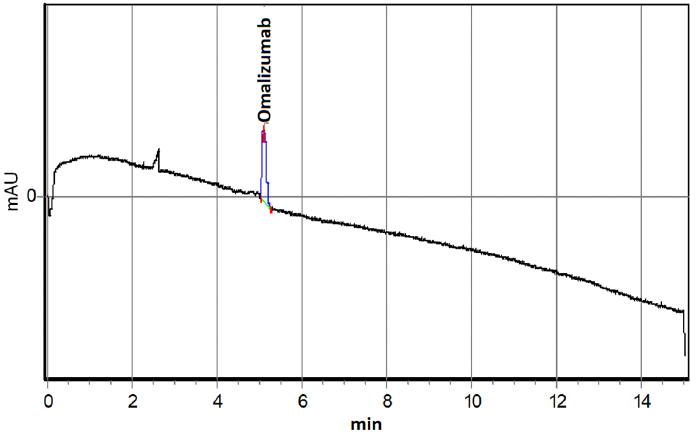
Figure 1. Electropherogram of an 0.6 µM Omalizumab solution.